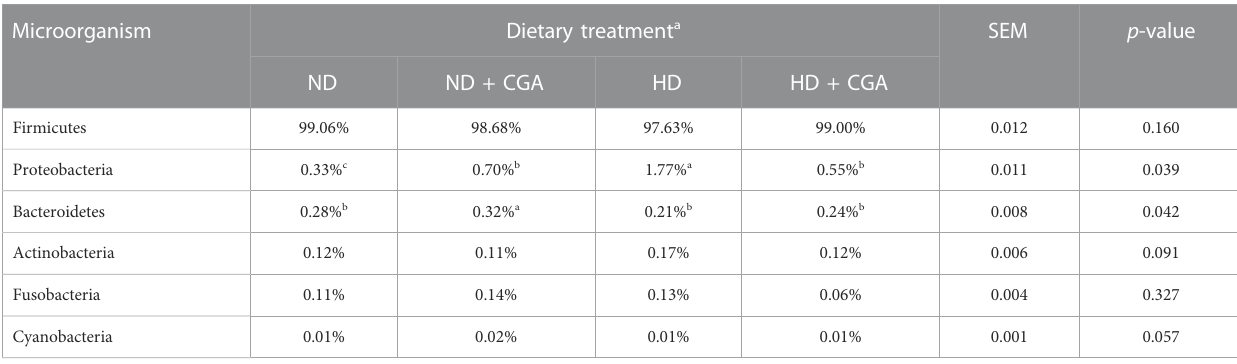
TABLE 4 Composition of ileum microbiota of broilers at phylum